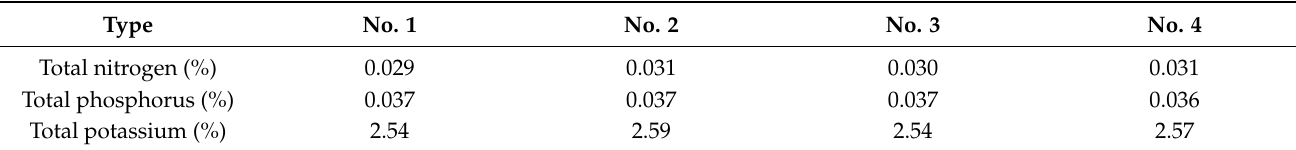
Table 3. Total nutrient content of the soil.